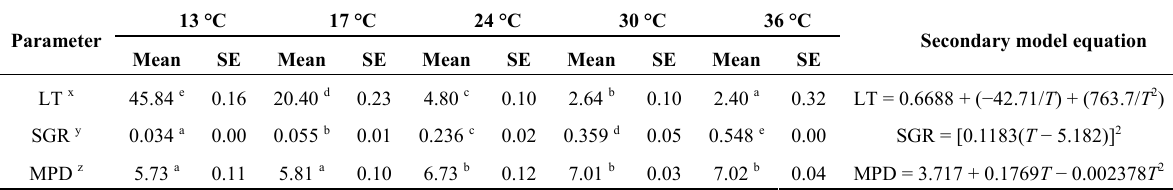
Table 1. Lag time, SGR and MPD of E. coli O157:H7 in perilla leaves and developed secondary